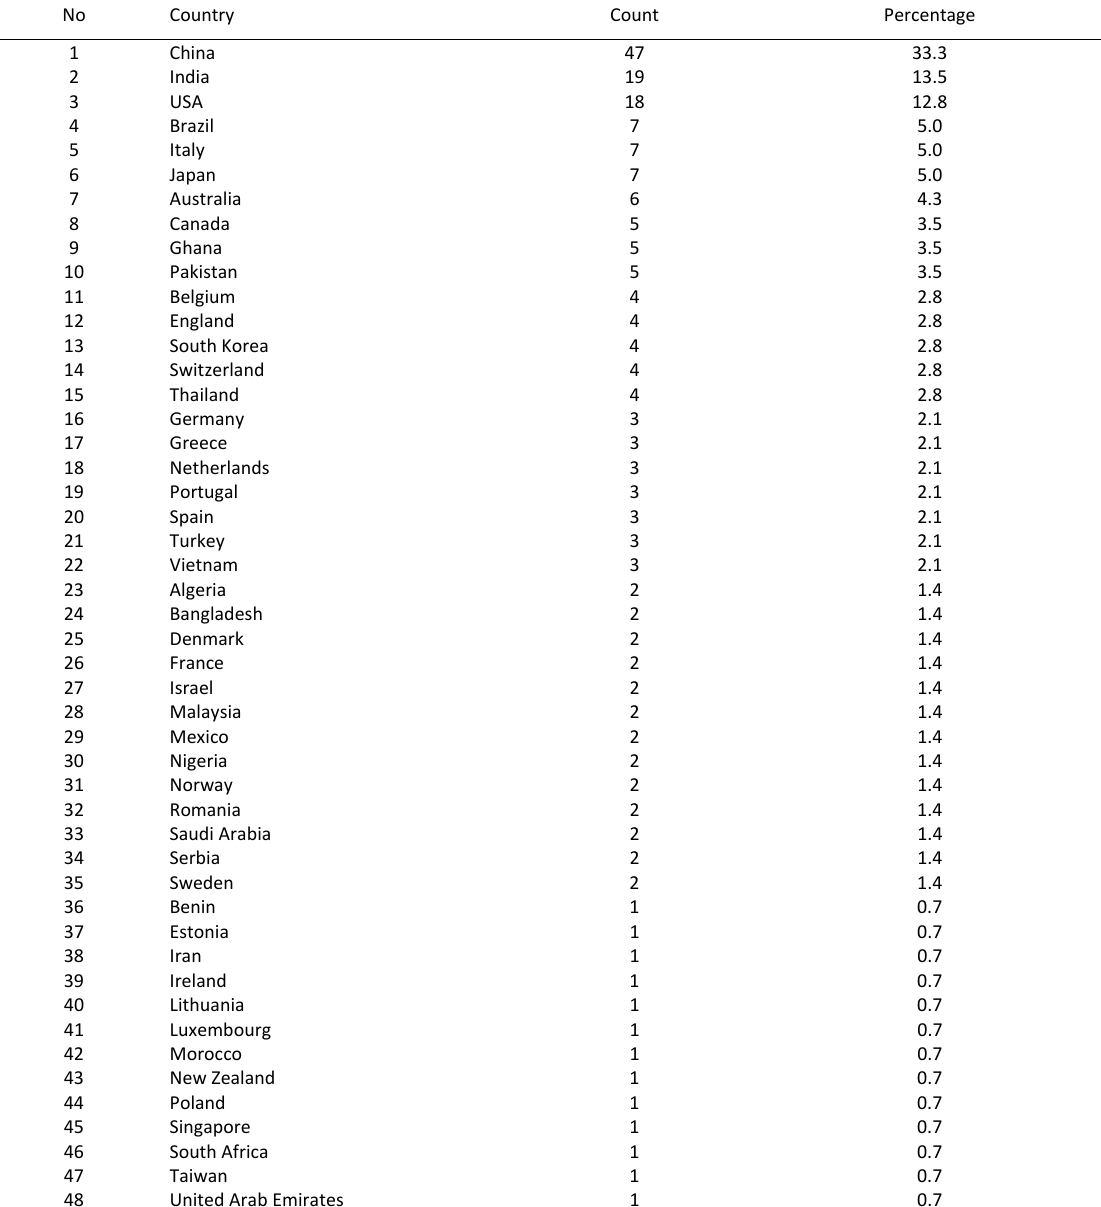
Table 3: Geographical distribution of articles